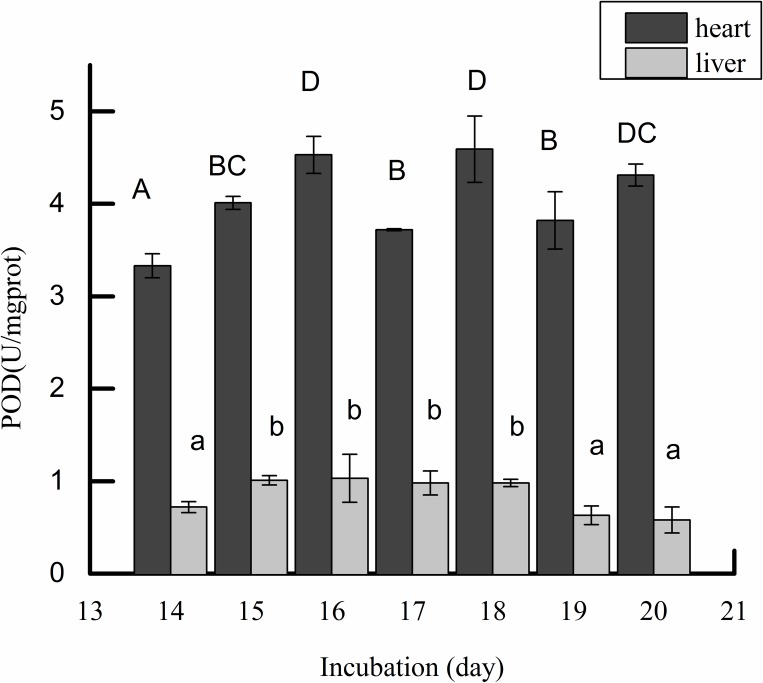
Effect of incubation day on POD activity in embryonic liver and heart.Note: The POD activity of heart and liver tissues was determined at days 14 to 20. The value of each fraction was the mean± standard deviation (n = 3), different letters (a, b) above columns indicate significant differences (p<0.05) in liver tissues, different letters (A, B) above columns indicate significant differences (p<0.05) in heart tissues.